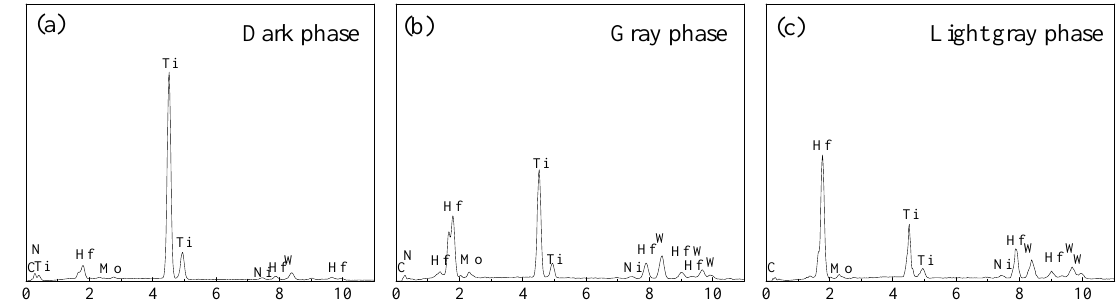
Figure 3. Energy dispersive spectrometry (EDS) results of the phases in TiC 0.7 N 0.3 ‐ HfC ‐ WC ‐ Ni ‐ Mo cermet tool materials: ( a ) EDS results of the dark phase; ( b ) EDS results of the gray phase; ( c ) EDS results of the light gray phase.